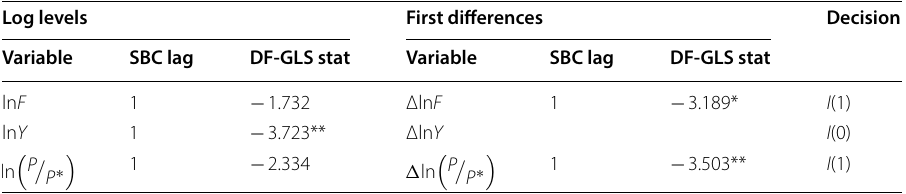
The optimal lag and bandwidth used are based on the Schwarz Bayesian Criterion